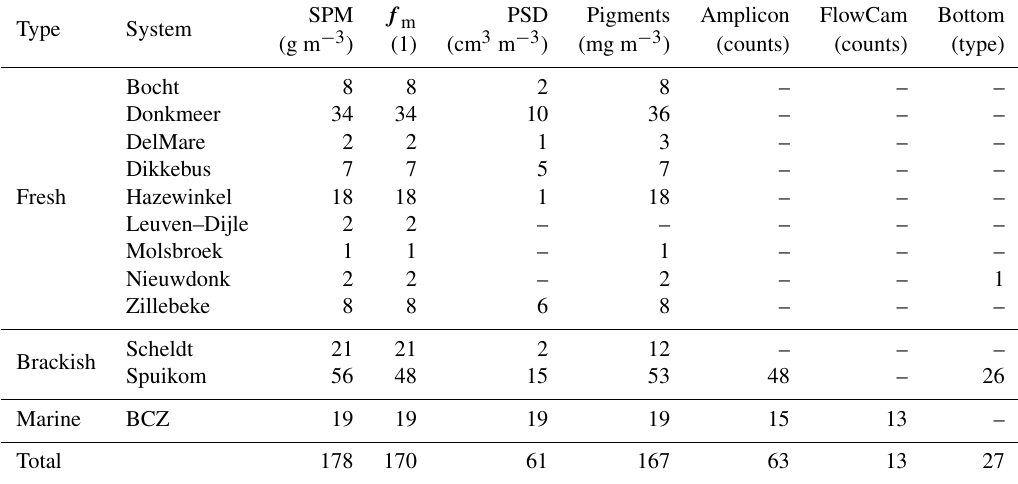
Table 5. Summary of measured and derived biogeochemical parameters per water